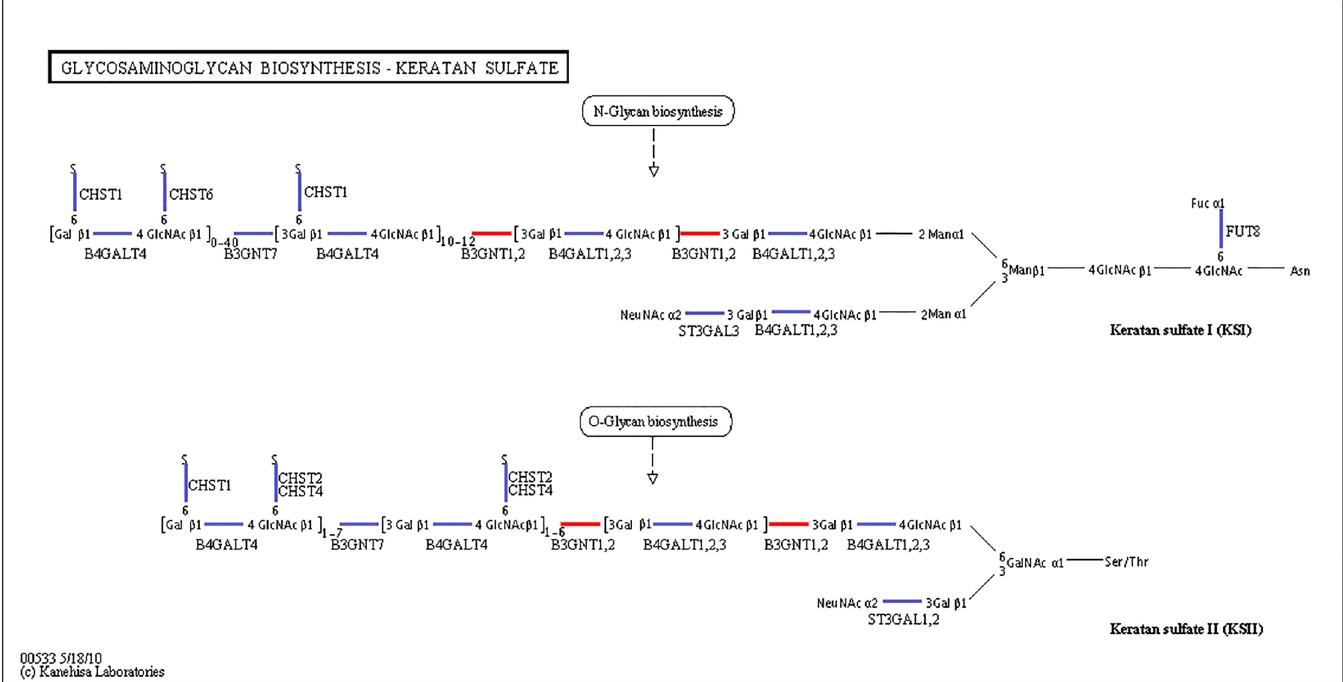
Fig 2. Pathways of glycosaminoglycan biosynthesis: keratan sulfate (ko00533). The red line indicates that the genes were up-regulated.